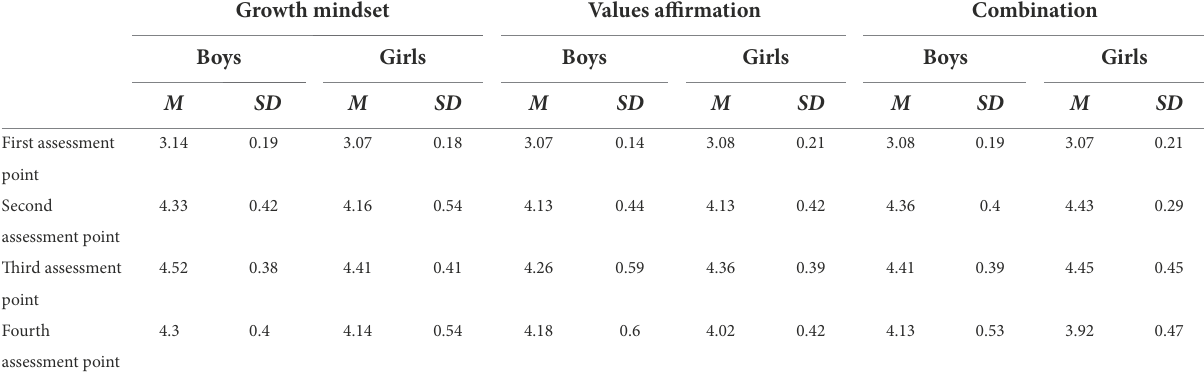
TABLE 2 Means and standard deviations of sense of belonging for all measurement points, split by gender and intervention method. Growth mindset Values